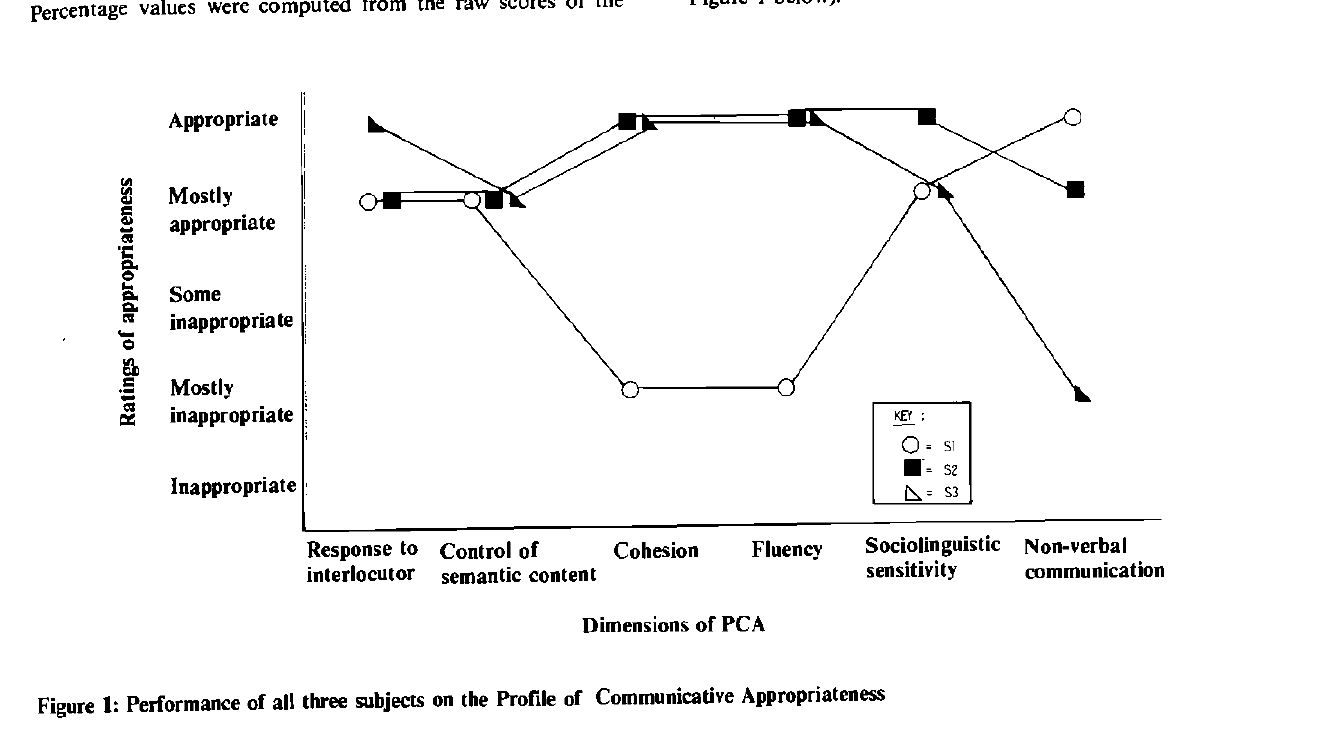
Figure 1: Performance of all three subjects on the Profile of Communicative